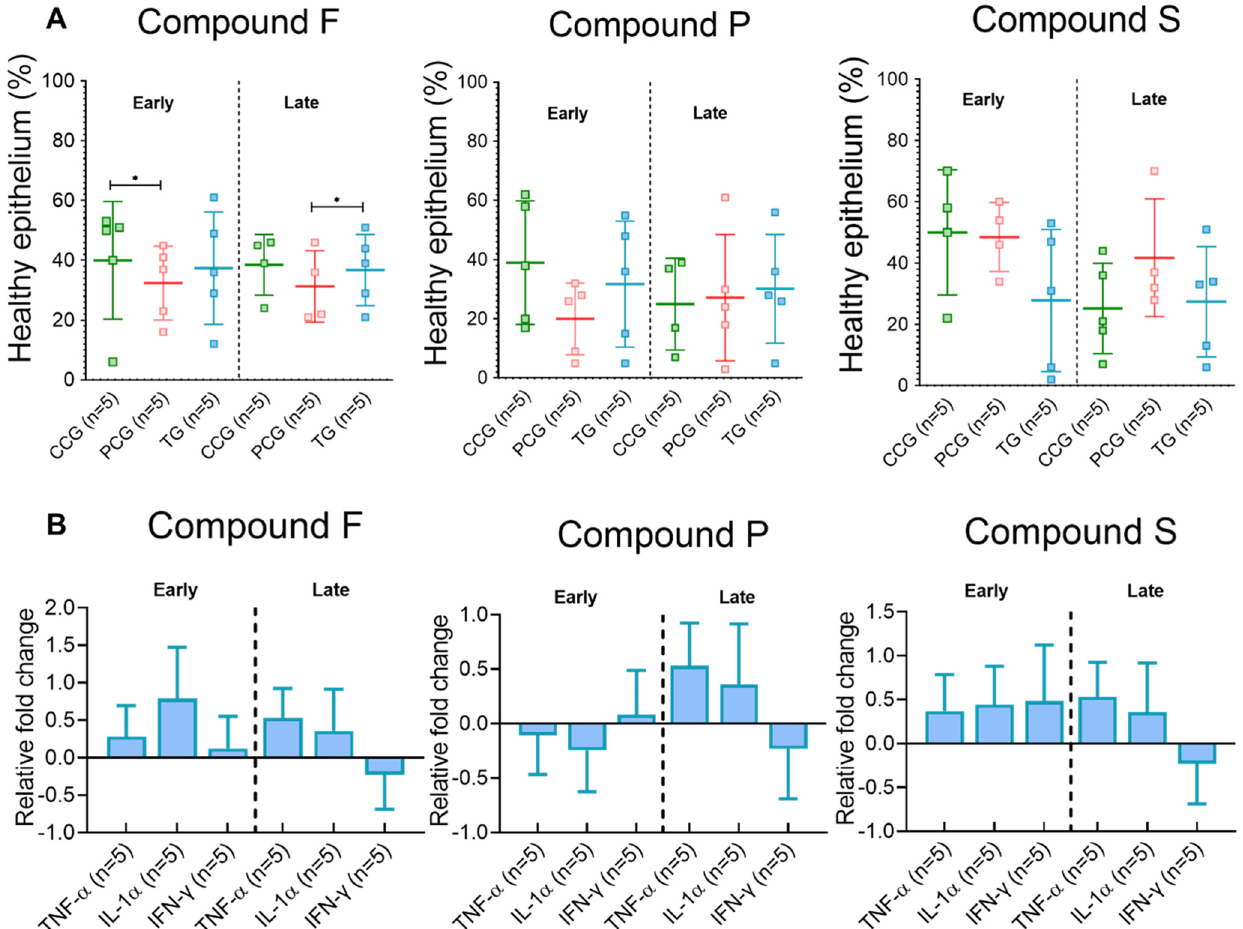
Figure 2. Microscopical changes and gene expression data from explants challenged with L. intracellularis . ( A ) Histopathology assessment. Horizontal lines represent group mean, and whiskers depict standard deviation from the mean. ( B ) Gene expression data is reported as fold change from TG samples using the PCG as reference. Compound control group (CCG), pathogen control group (PCG), treatment group (TG). Bars represent mean mRNA levels; whiskers depict standard deviation from the mean. Star denotes significant difference ( p ≤ 0.05).